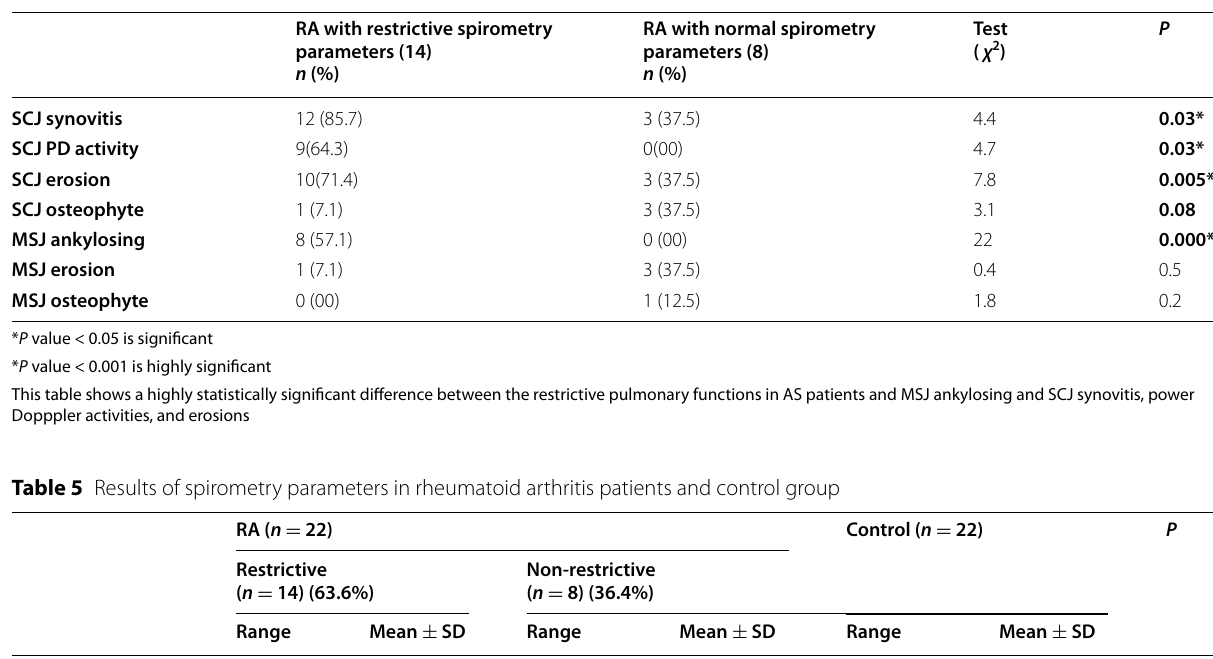
Table 4 Association of the ultrasonographic changes with restrictive spirometry parameters in rheumatoid arthritis patients